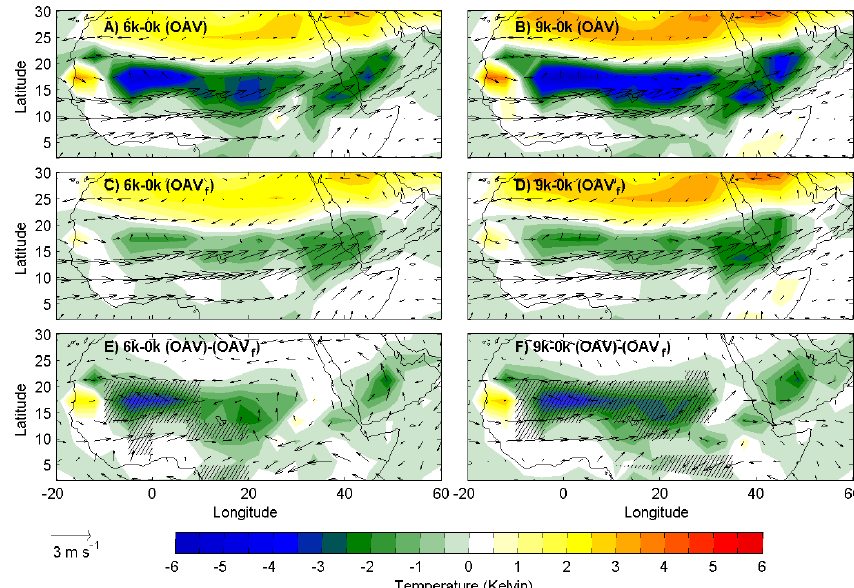
Figure 4. As in Fig. 3 but for changes in summer surface temperature and 700hPa winds. Hatched areas in (e, f) display significant temper- ature differences (95% confidence level) according to both a (non-parametric) Wilcoxon–Mann–Whitney test and a Student’s t